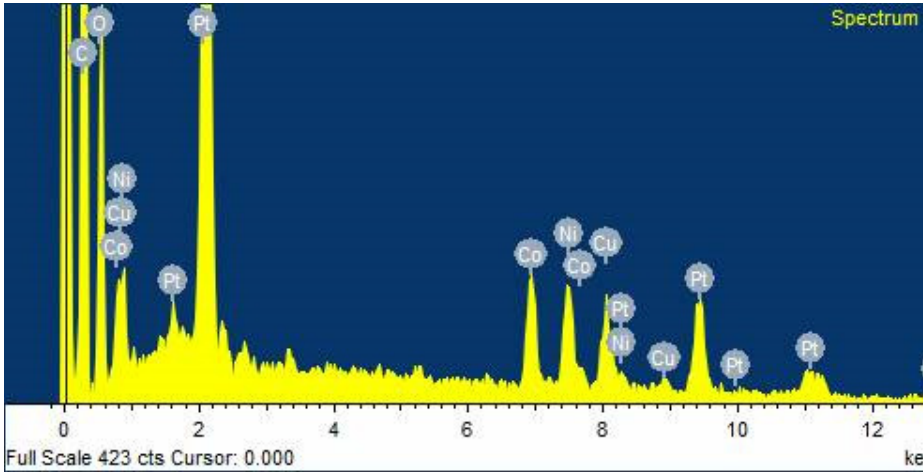
Figure 5. EDX spectrum of PtNiCo/rGO 200